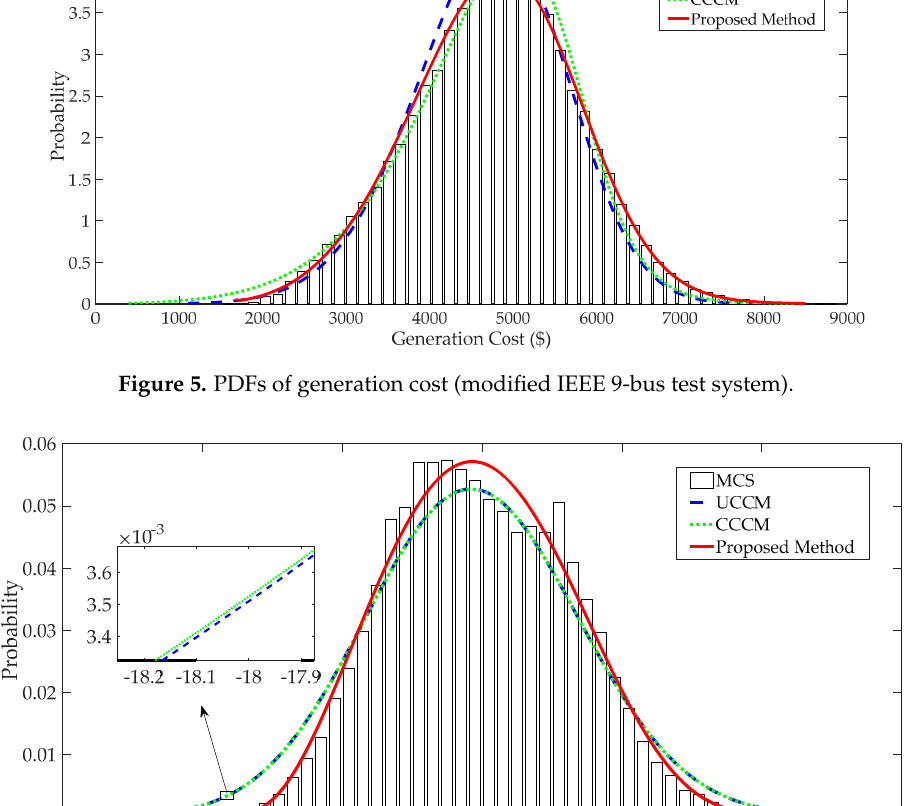
Table 6. Parameters of Weibull distributions (modified IEEE 118-bus test system).